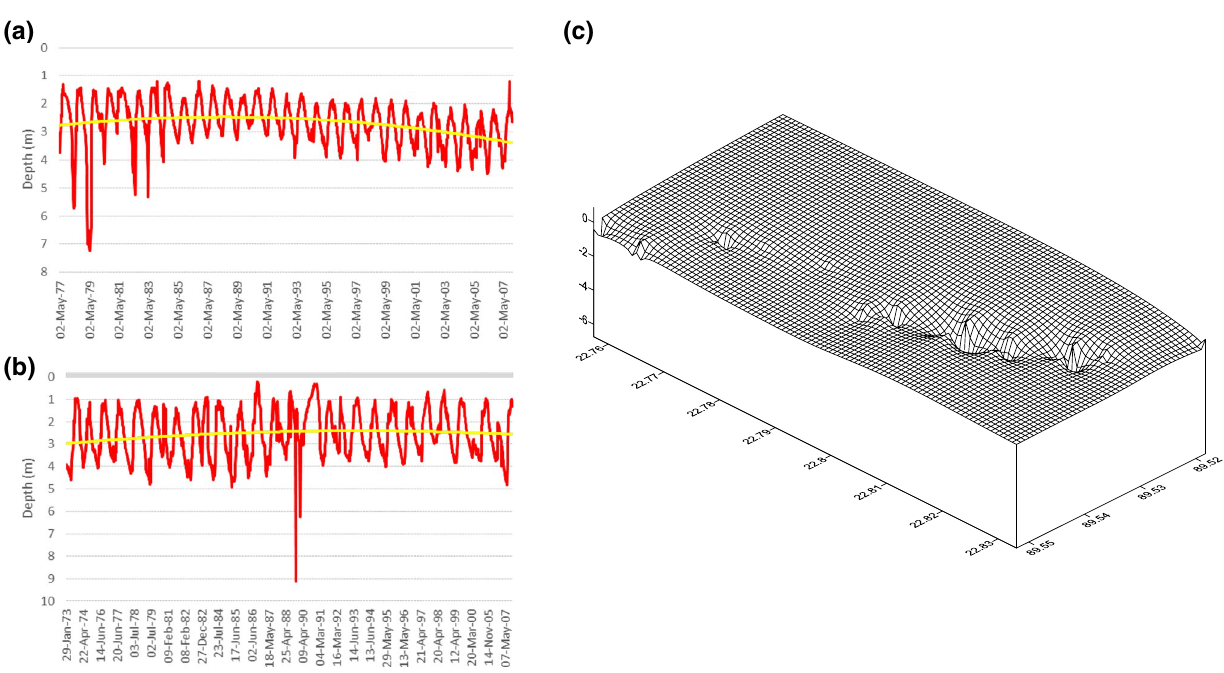
Fig. 2 Measurements of groundwater tables over 1987–2007 in two observation wells in the basin area ( a , b ). c Exhibits the bathymetric meas- urement of the river